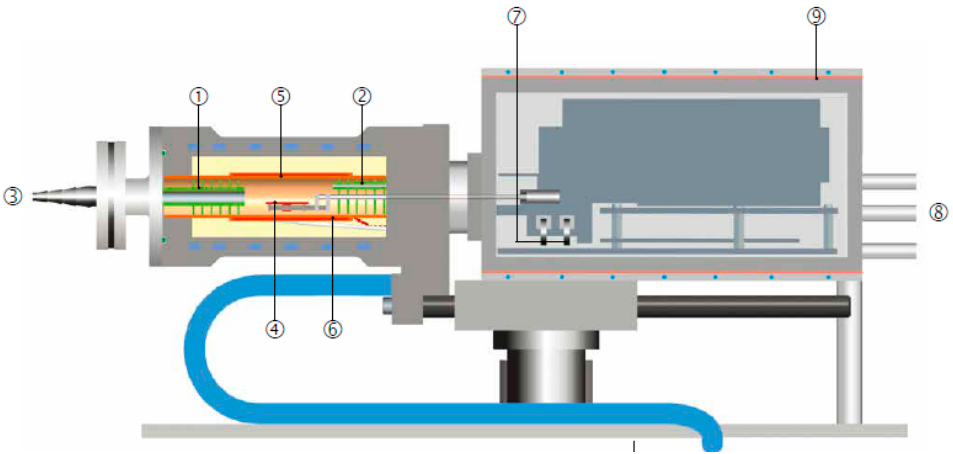
Figure 1. TGA and DSC (1: heat filter; 2: reaction gas capillary; 3: gas outlet; 4: temperature sensor; 5: furnace heating plate; 6: temperature sensor; 7: weight calibration; 8: gas connection port; and 9: